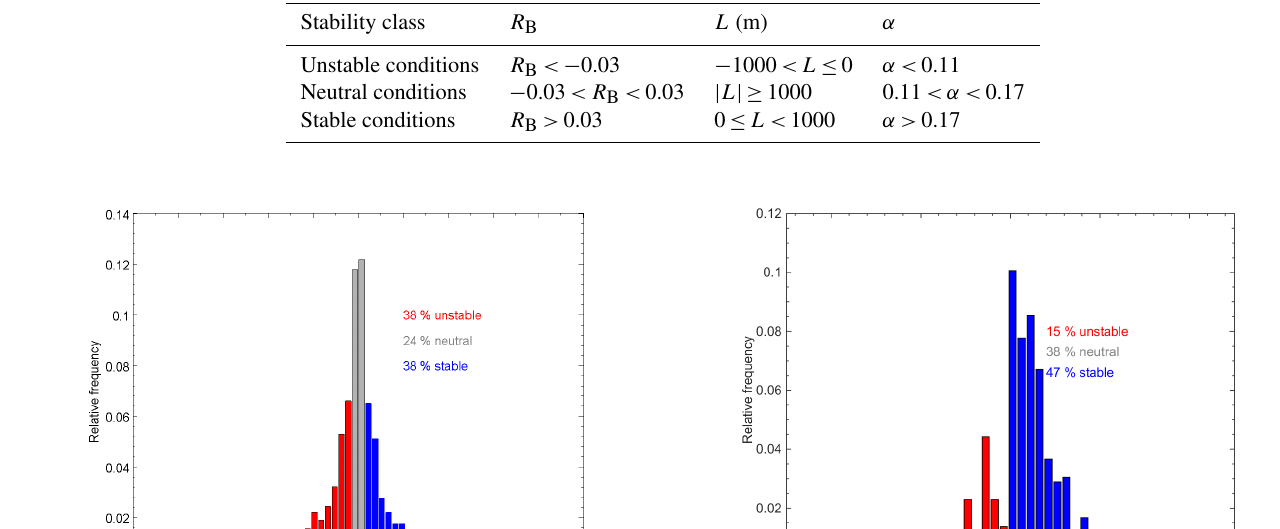
Table 2. Defined stability regimes.